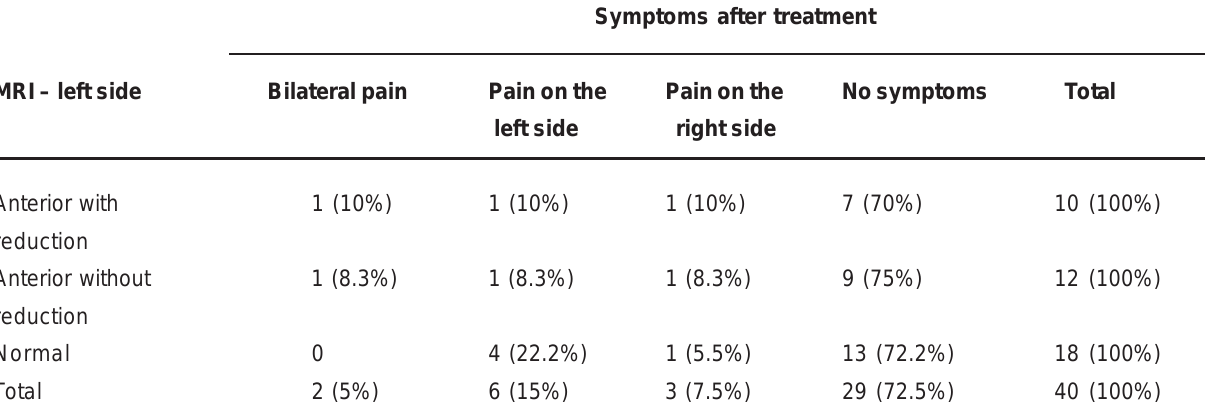
TABLE 3 - Distribution of the patients according to the MRI results for the left side and symptoms after